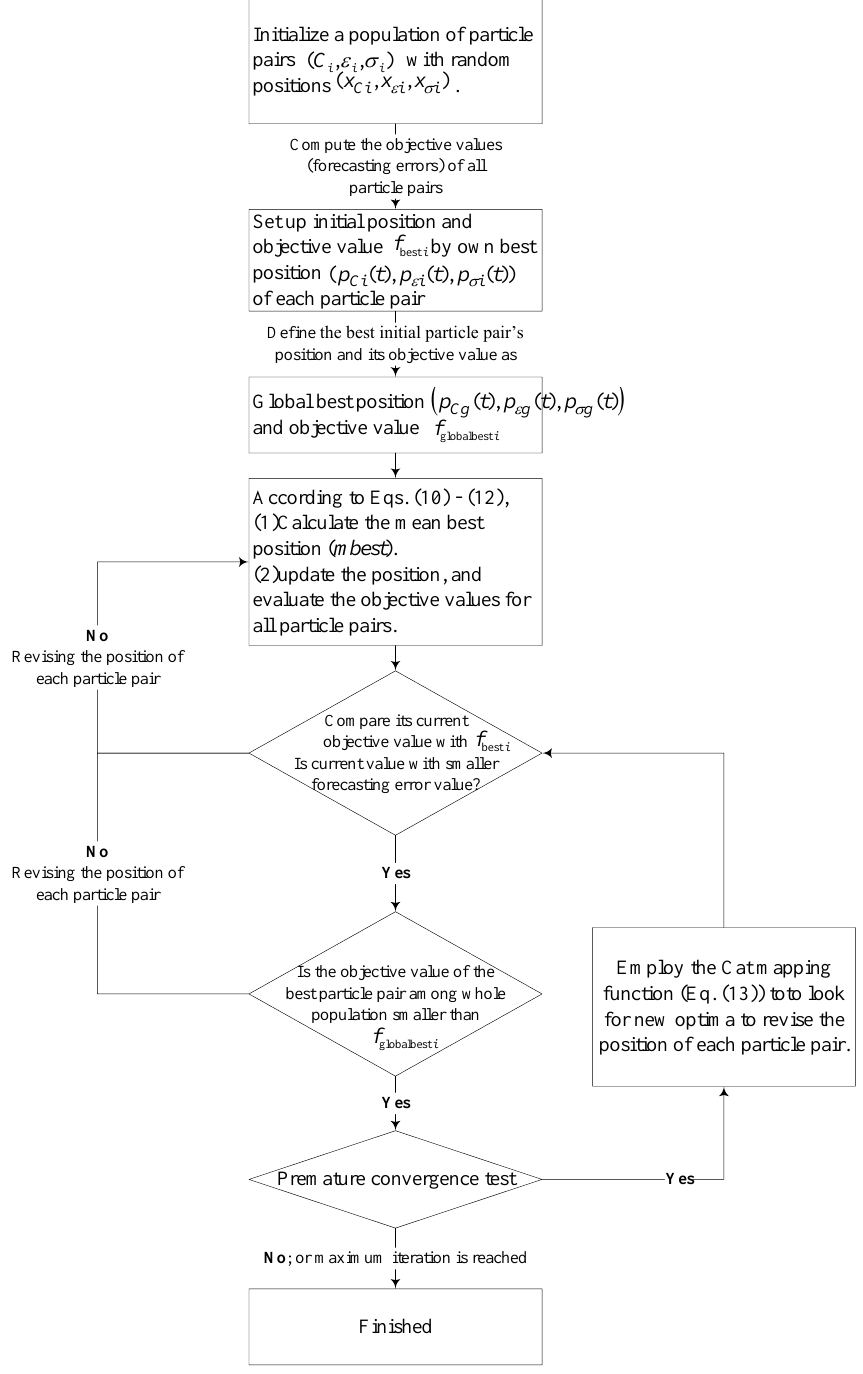
Figure 1. Quantum particle swarm optimization flowchart.